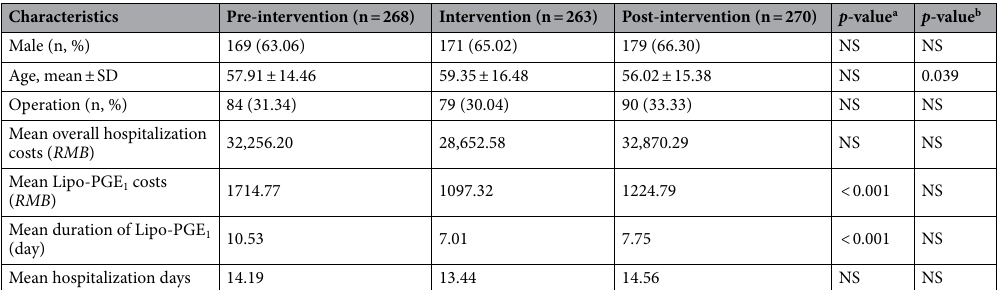
Table 4. General characteristics of patients and expenditure of Lipo-PGE 1 in pre-, during, and post- intervention periods. a The statistical differences between pre-intervention and intervention groups. b The statistical differences between intervention and post-intervention groups. NS not significant ( P >